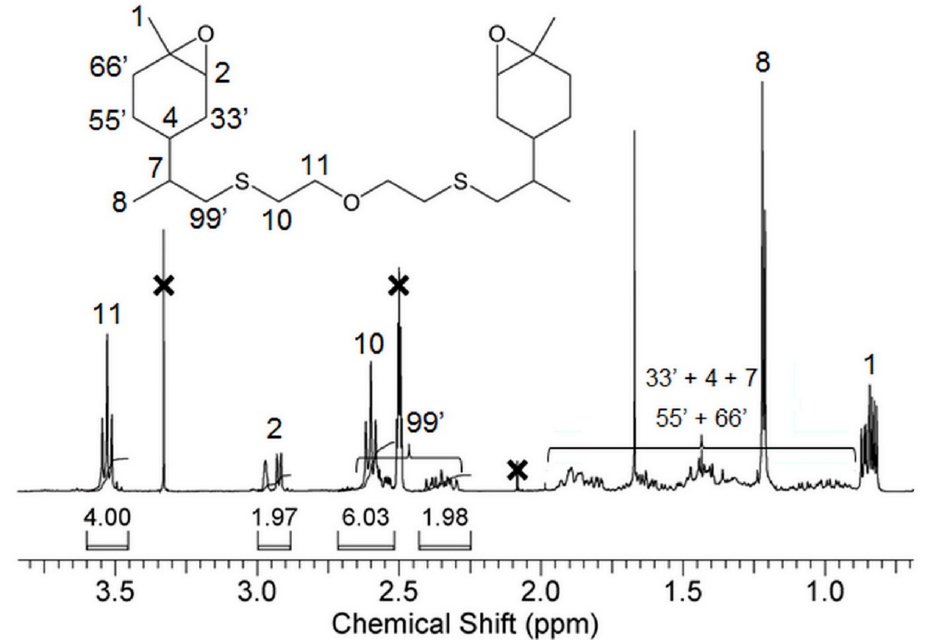
Figure 2. 1 H-NMR spectrum of bis-LO recorded in deuterated DMSO.